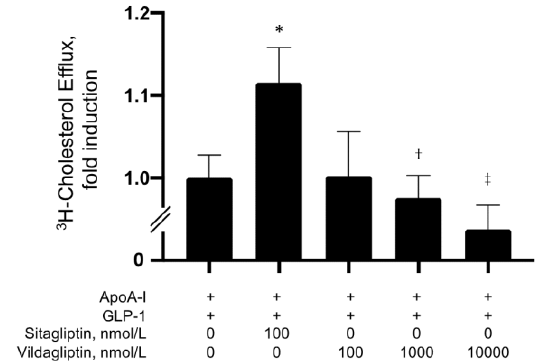
Figure 1. Effect of sitagliptin in the presence ( A ) or absence ( B ) of GLP-1 (10 nmol/L) on apoA1- mediated cholesterol efflux. Values represent mean ± SD. * p < 0.01; † p < 0.05 vs. apoA-I (–), ‡ p < 0.05 vs. apoA1 + GLP-1. Each group, n = 5–6.